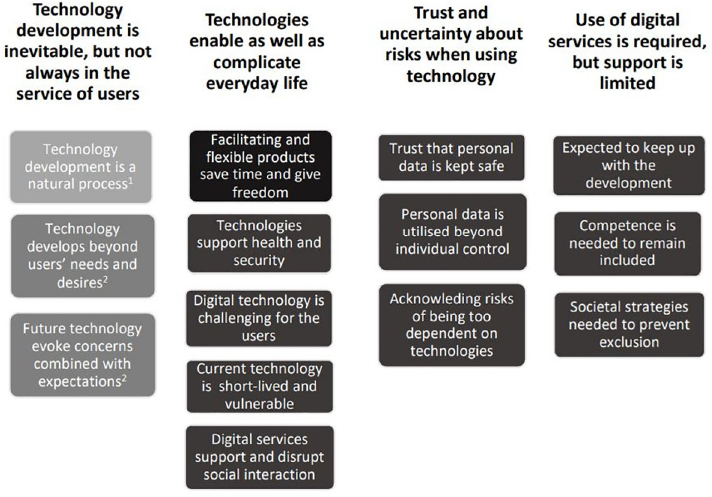
Fig 1. Overview of categories and sub-categories, including a brief summary of generational differences and similarities. 1 Sub-category representing only 50–59 and 70–79 year olds. 2 Sub-category representing mainly 50–59 and 70–79 year